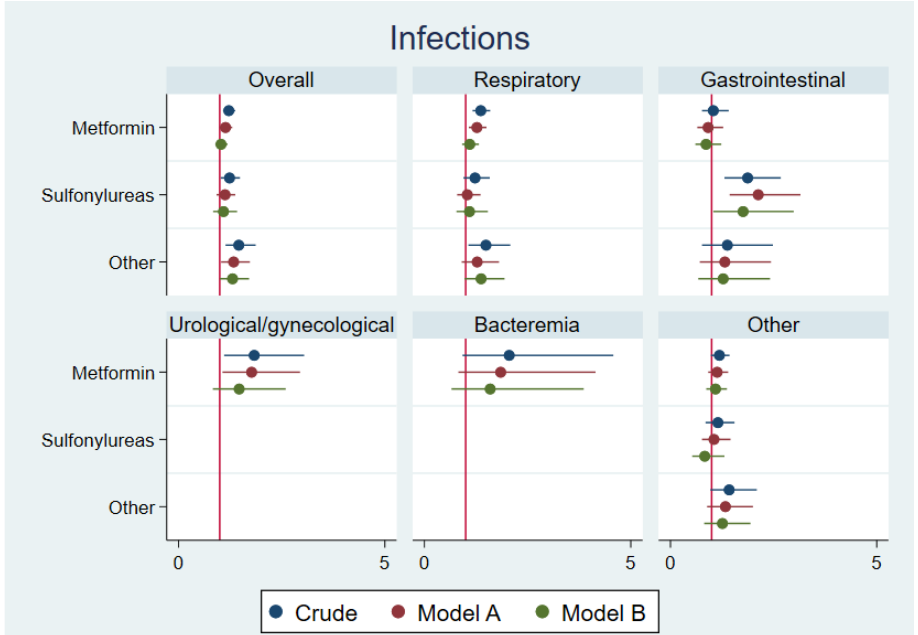
Figure 2. Shows the HRs for overall child infections, and types of infections in the first year of life after paternal use of non-insulin anti-hyperglycemic agents (stratified according to metformin, sul- fonylureas, others). In model A, we adjusted for maternal and paternal age, maternal and paternal comorbidity, mother’s use of antidiabetics, parity, sex of the child, calendar year, and other types of non-insulin anti-hyperglycemic agents prior to conception. In model B, we added maternal BMI and maternal